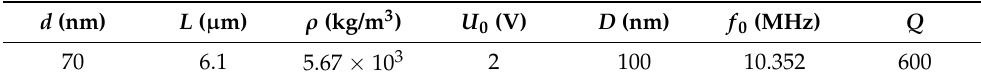
Table 1. Resonator parameters.